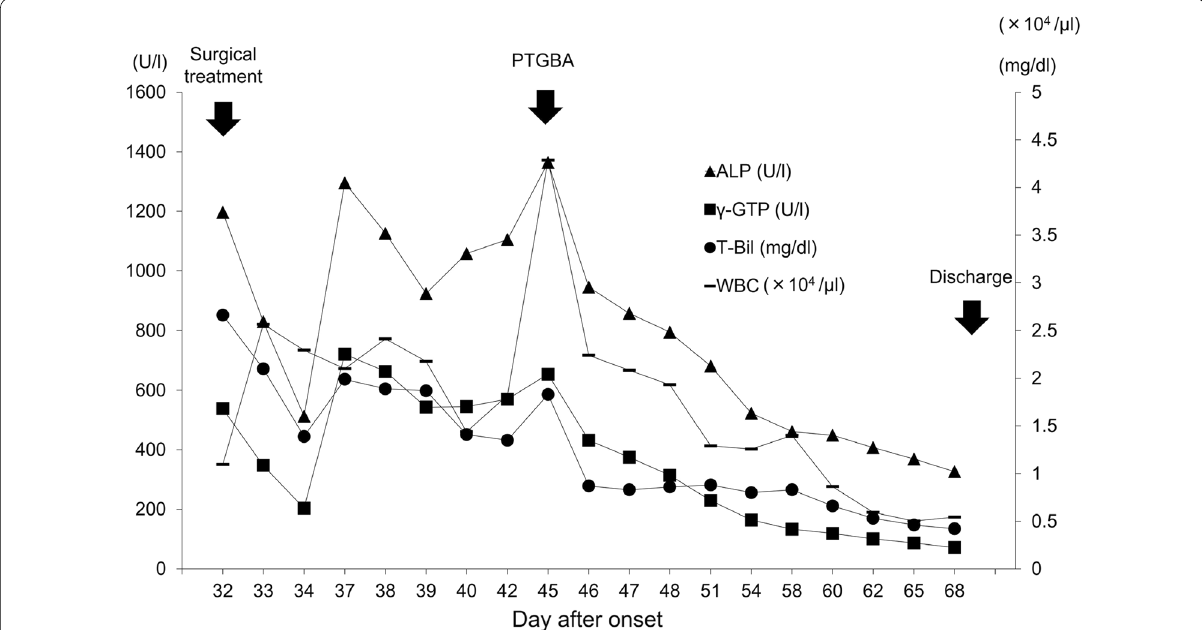
Fig. 7 Clinical course of the levels of white blood cell count, serum bilirubin, and biliary enzymes after surgical treatment. ALP alkaline phosphatase, ɣ -GTP gamma-glutaryl phosphatase, T-Bil total bilirubin, WBC white blood cell count, PTGBA percutaneous transhepatic gallbladder aspiration